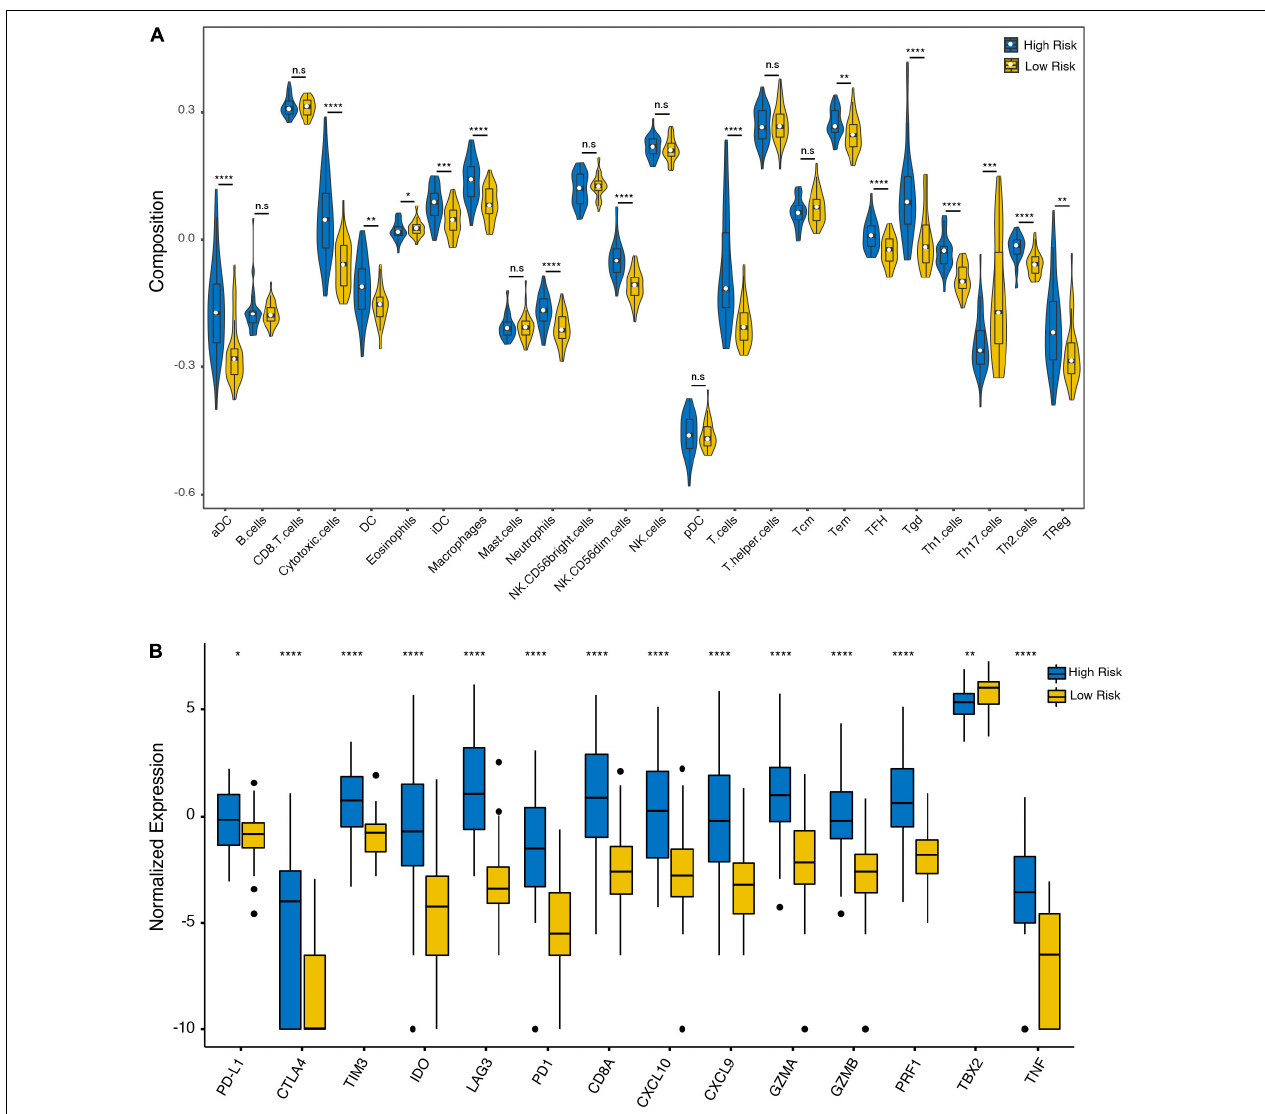
FIGURE 5 | Immune cell and checkpoint analysis between the high- and low-risk UM groups. (A) Differential proportions of immune cells between high- and low-risk groups in the TCGA cohort. (B) Differential expression of immune checkpoint immune checkpoints between the high- and low-risk groups in the TCGA cohort. * p < 0.05; ** p < 0.01; *** p < 0.001; **** p < 0.0001; and n.s, no